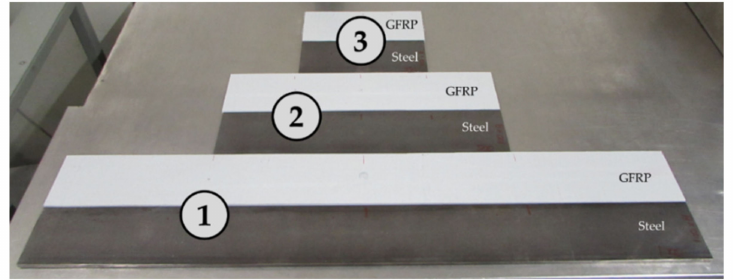
Figure 9. Experimental